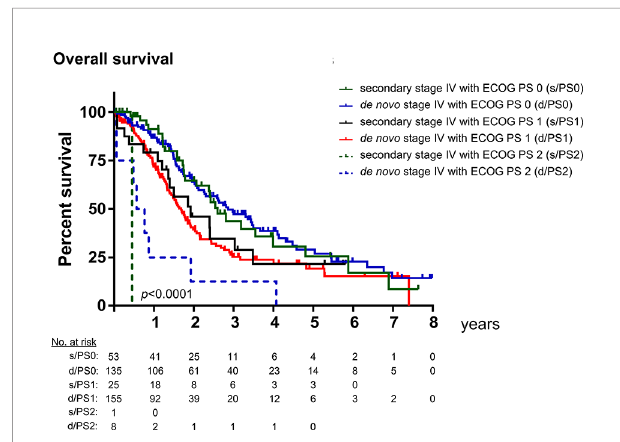
FIGURE 3 | Overall survival of TKI-treated EGFR + NSCLC patients with de novo vs. secondary metastatic disease by the ECOG performance status. Median overall survival (OS) from the diagnosis of metastatic disease for TKI- treated EGFR + NSCLC was 32 months (standard error [SE] 3.0) for patients with secondary stage IV disease and ECOG performance status 0 (PS 0, n = 53), and 34 months (SE 4.3) for patients with de novo stage IV disease and ECOG PS 0 (n = 135); 23 months (SE 7.2) for patients with secondary stage IV disease and ECOG PS 1 (n = 25), and 20 months (SE 1.5) for patients with de novo stage IV disease with EM (n = 154); 5 months for the single patient with secondary stage IV disease and ECOG PS 2 (n = 1), and 6.7 months (SE 2.4) for patients with de novo stage IV disease and ECOG PS 2 (n = 8, logrank p < 0.0001). In a bivariable Cox regression, only the ECOG PS at diagnosis of stage IV disease (HR = 1.66, p < 0.0001 for ECOG PS 1; HR = 4.65, p < 0.0001 for ECOG PS 2), but not presence of de novo vs. secondary metastatic disease (HR = 1.02, p = 0.91) was a signi fi cant predictor for OS in our entire cohort (n =